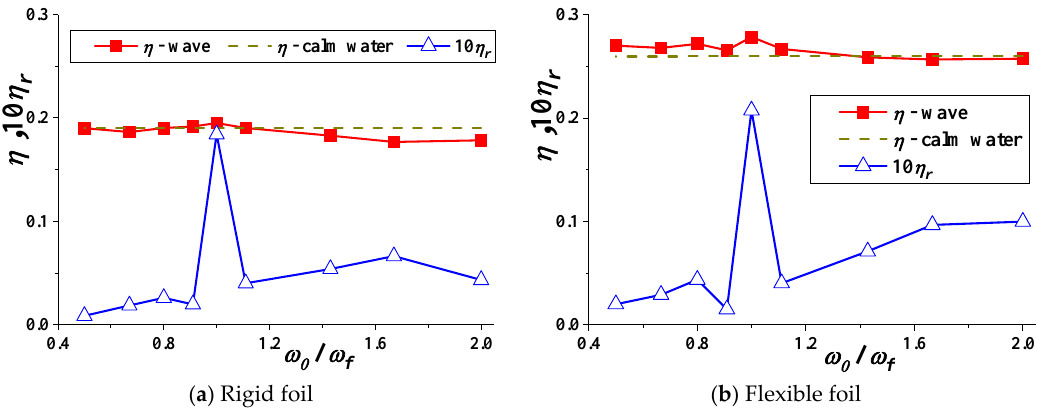
Figure 7. The percentage of wave energy recovery η r and propulsive efficiency η for the foil versus wave encounter frequency.